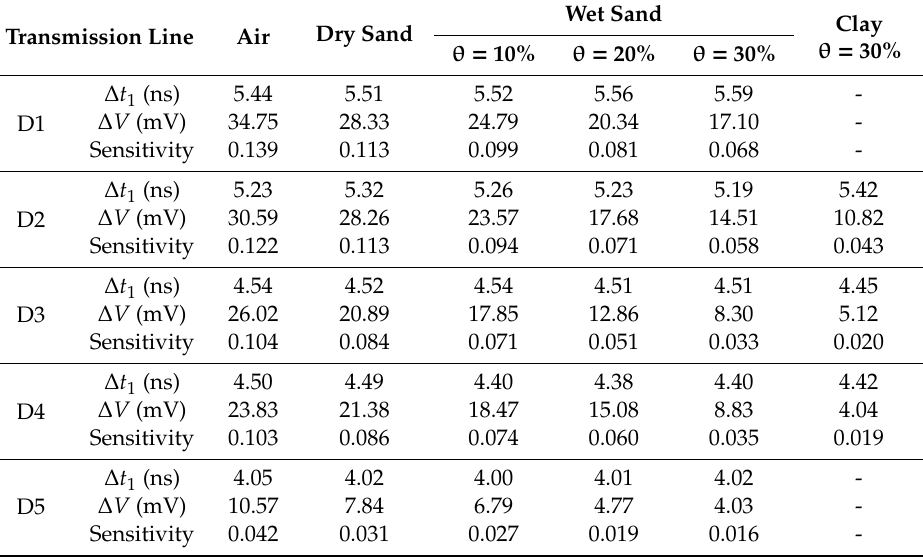
Table 3. Travel time of electromagnetic waves reflected from defects ( ∆ t 1 ), amplitude di ff erence between the peak and minimum ( ∆ V ), and sensitivity of signals reflected at the